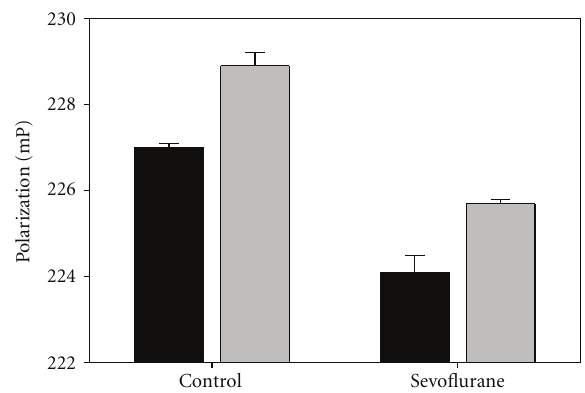
Figure 5: Sevoflurane decreased intrinsic fluorescence polarization. HSA (10mg/mL) was treated with sevoflurane and then analyzed for fluorescence polarization and compared against control with (gray bars) and without (black bars) isotonic saline. Data are from multiple readings from two independent experiments and presented as M ±